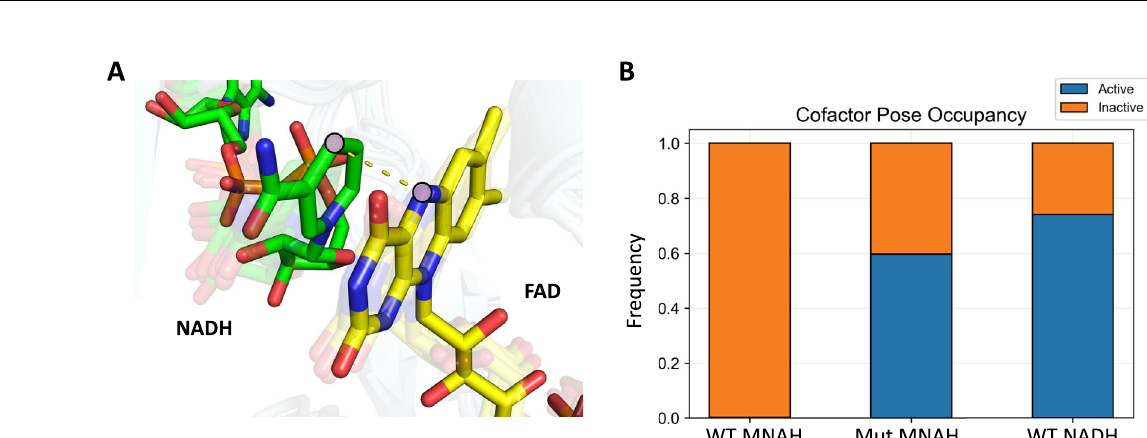
Fig. 5 | Comparison of Rossman fold loop fl exibility between wild type and engineered Lp Nox. 40 random frames are selected and aligned from each simu- lationtovisualizetherangeofconformationssampled.Theloopregionsmeasured arehighlightedinorange(residues153-157,177-188,and238-242)andenvelopethe AMP portion of the native NADH cofactor. The three mutated positions in the binding site (D177W, G178E, and V240L) are colored as violet spheres. A WT with MNAH bound displays high fl exibility as indicated by large displacement of the strands.The fl uctuationsimpedeorganizationoftheactivesitetosupportcofactor